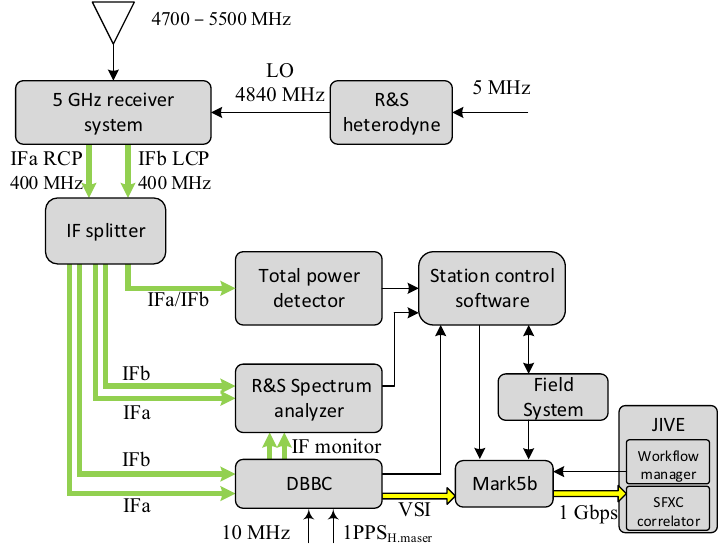
Fig. 3. Connection scheme of the receiving and recording equipment for e-VLBI experiments at RT-32. The data acquisition system consists of two units DBBC with Mk5b